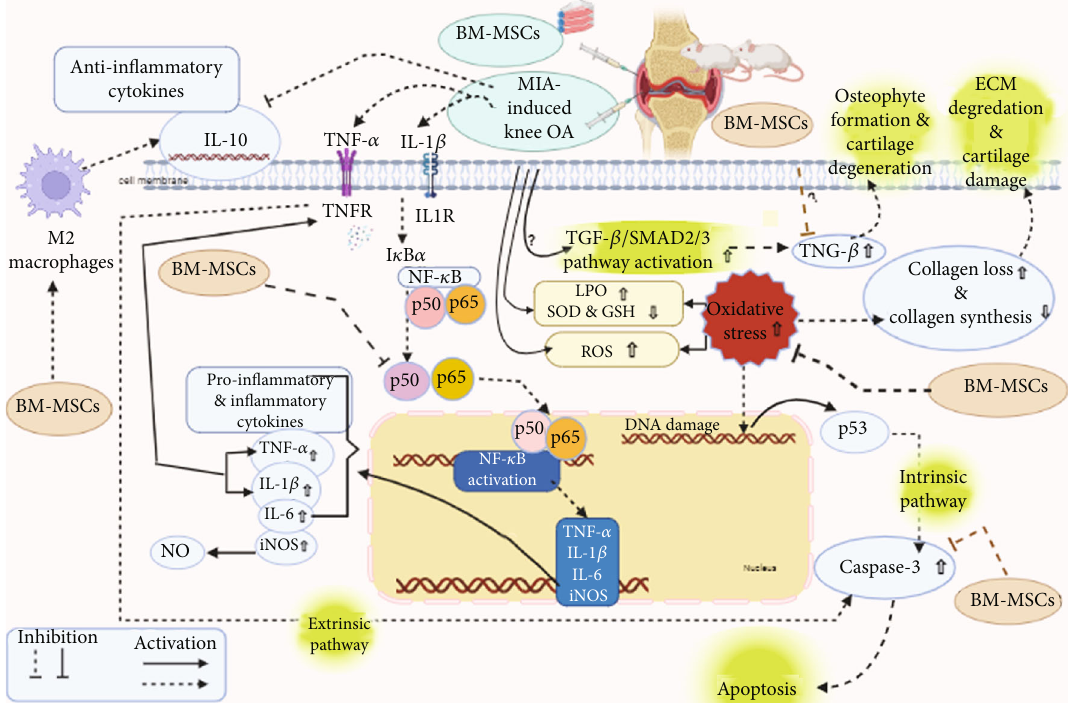
Figure 10: The therapeutic e ff ect of BMMSCs on cartilage damage due to in fl ammation, extracellular matrix (ECM) degradation, and apoptosis in MIA-induced knee